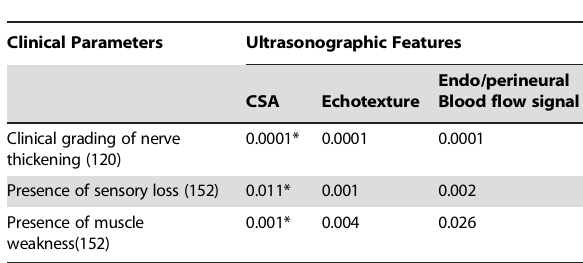
Table 4. Statistical significance (p value) of the relationship of clinical parameters versus ultrasonographic features in 152 peripheral nerves of leprosy